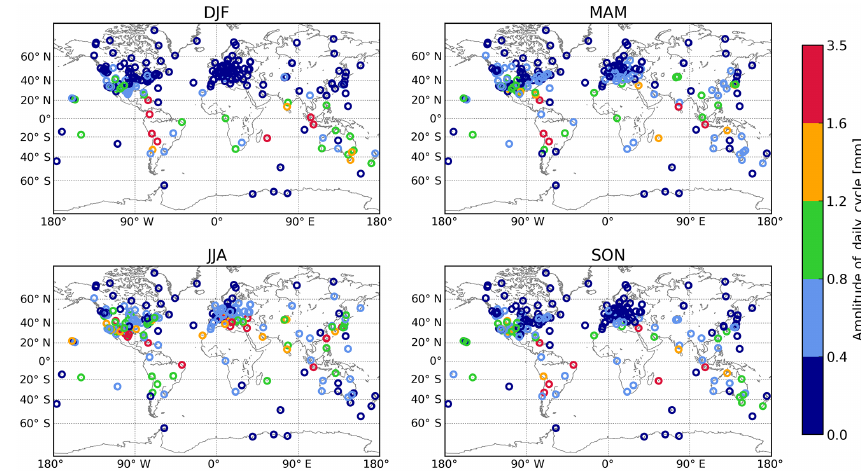
Figure 4. Season-averaged amplitude of the daily cycle of TCWV for each GNSS station in millimetres.